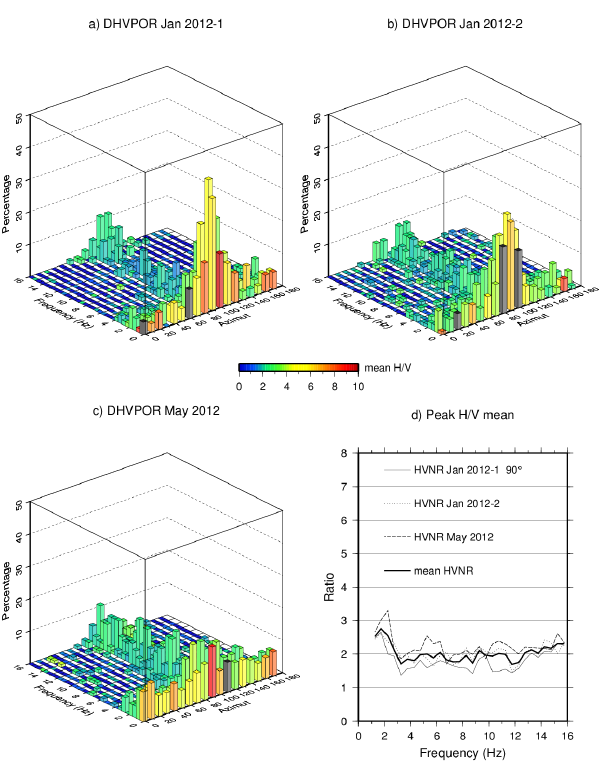
Fig. 9. Results of noise measurement at site T6S (1627 landslide): Fig. 9 - Results of noise measurement at site T6S (1627 landslide): DHVPOR histograms relative to 2 DHVPOR histograms relative to measurements of January (a, b) measurements of January (a, b) and May 2012 (c) and mean values of H/V peaks oriented due 3 and May 2012 (c) and mean values of H/V peaks oriented due N90°; thick solid line represents the average of noise H/V peak values derived from different 4 90 ◦ N; thick solid line represents the average of noise H/V peak measurements. Note that the first of the two January measurements was simultaneous with that at 5 values derived from different measurements. Note that the first of site T6 (Fig. 8b), whereas the second one was simultaneous with that at sites T6N (Fig. 10a). 6 the two January measurements was simultaneous with that at site T6 (Fig. 8b), whereas the second one was simultaneous with that at site T6N (Fig. 10a).